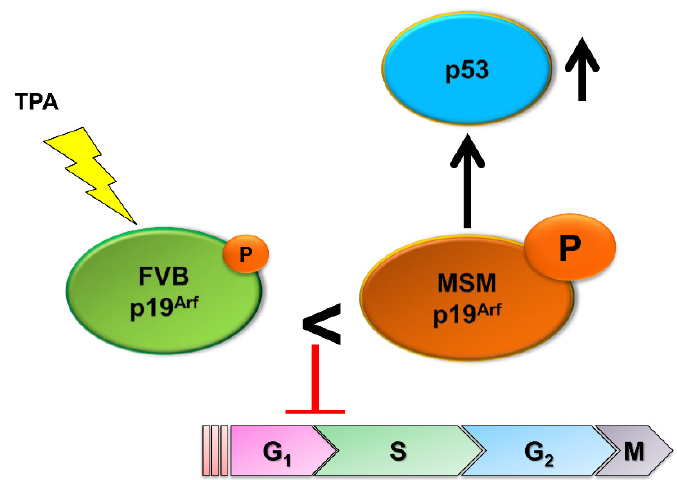
Figure 4. Mechanism of action of MSMp19 Arf in tumor resistance. The protein level of MSMp19 Arf is higher than that of FVBp19 Arf in the presence of TPA. The greater amount of p19 Arf more efficiently up-regulates p53 and downstream tumor suppressor genes, resulting in tumor resistance.